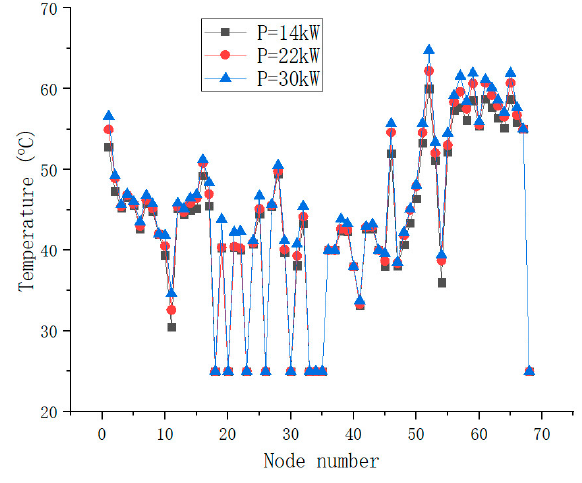
Figure 9. The TFD with the different motor output powers.